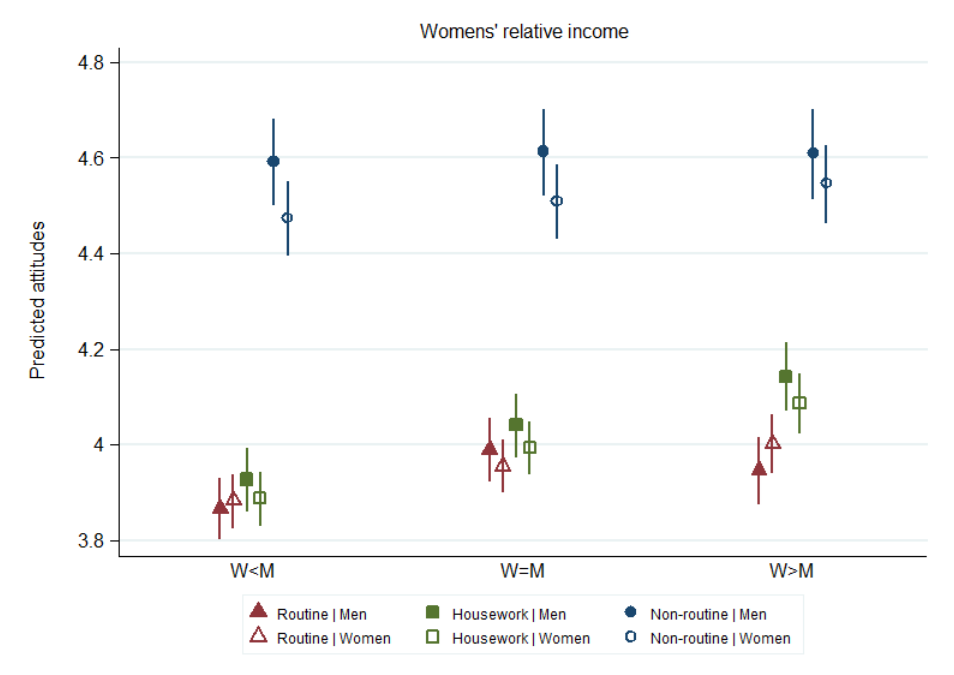
Figure 7 : Predicted attitudes towards housework by vignette couples’ relative